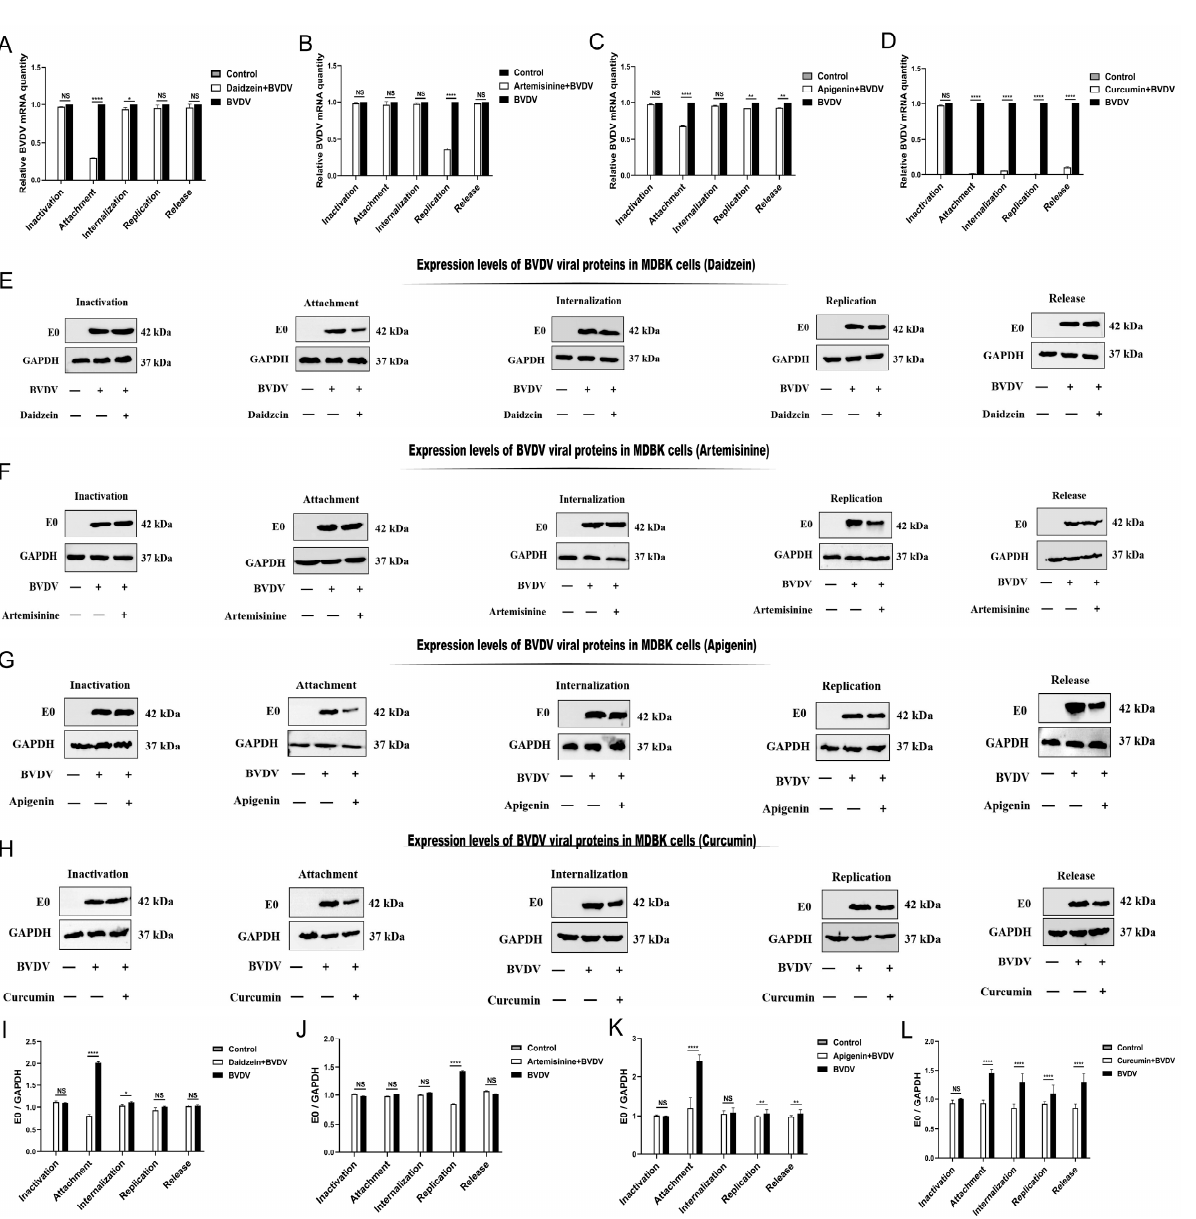
Figure 6. Results of the effect of herbal monomers on the replication cycle of BVDV virus. Daidzein ( A ): BVDV virus mRNA expression level in MDBK cells. ( E ): Expression levels of BVDV viral proteins in MDBK cells. ( I ): Gray value analysis of protein. Artemisinine ( B ): Expression level of BVDV virus mRNA in MDBK cells. ( F ): Expression levels of BVDV viral proteins in MDBK cells. ( J ): Gray value analysis of protein. Apigenin ( C ): Expression level of BVDV virus mRNA in MDBK cells. ( G ): Expression levels of BVDV viral proteins in MDBK cells. ( K ): Gray value analysis of protein. Curcumin ( D ): BVDV virus mRNA expression level in MDBK cells. ( H ): Expression levels of BVDV viral proteins in MDBK cells. ( L ): Gray value analysis of protein. NS: The difference was not significant. **** p < 0.0001, ** p < 0.01, * p < 0.05, n = 3. Data were presented as mean ± SD. "—" Indicates: not added. "+" indicates: